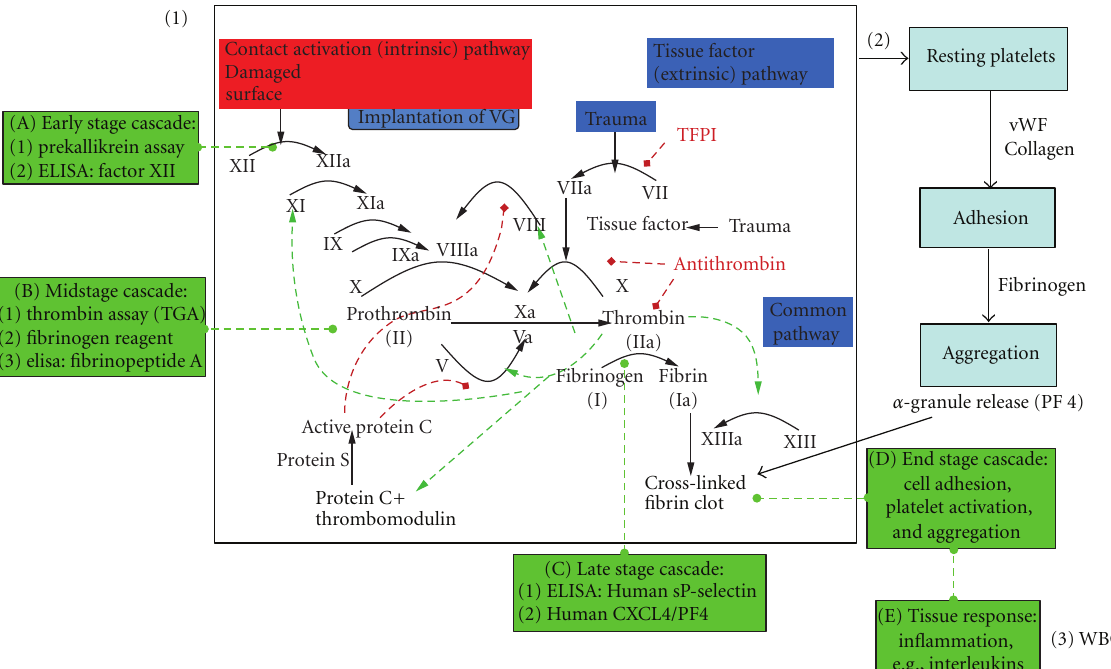
Figure 2: Intrinsic pathway of blood coagulation: highlighted are the main factors which are involved in blood coagulation. Numbered events distinguish as (1) biochemical, (2) platelets, and (3) whole blood (red and white blood cells). Image is adapted from http://en.wikipedia .org/wiki/File:Coagulation